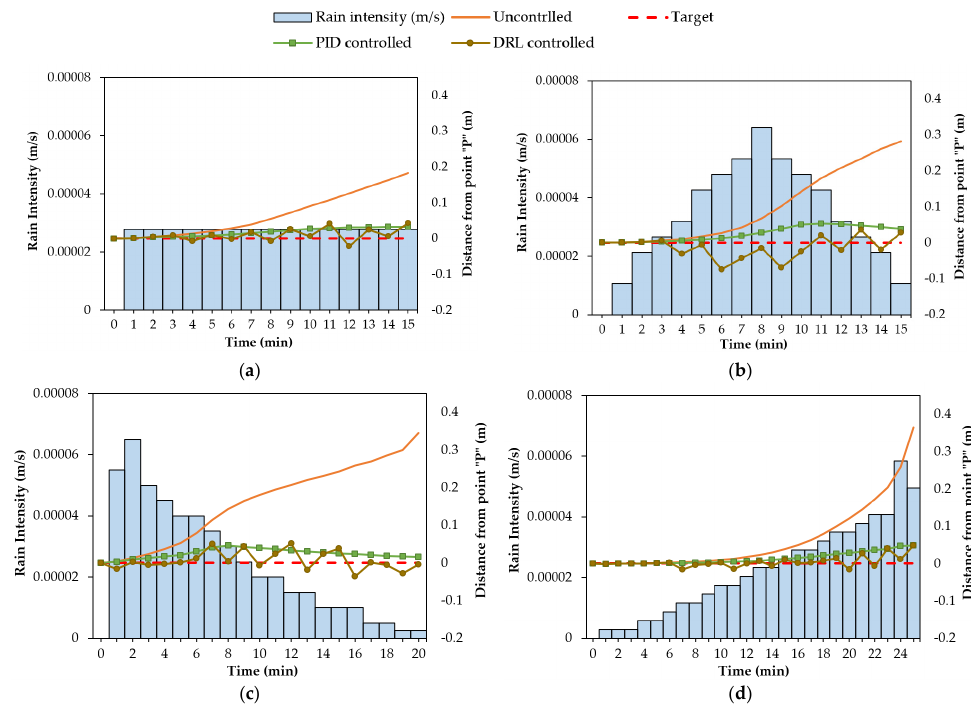
Figure 6. Distance of the water level from point “P” obtained with different control methods during rainfall events: ( a ) 15 min-constant; ( b ) 15 min-normal; ( c ) 20 min-descending; ( d ) 25 min-ascending. Table 6. RMSE values for the uncontrolled, PID-controlled, and DRL-controlled water levels during various rainfall events.